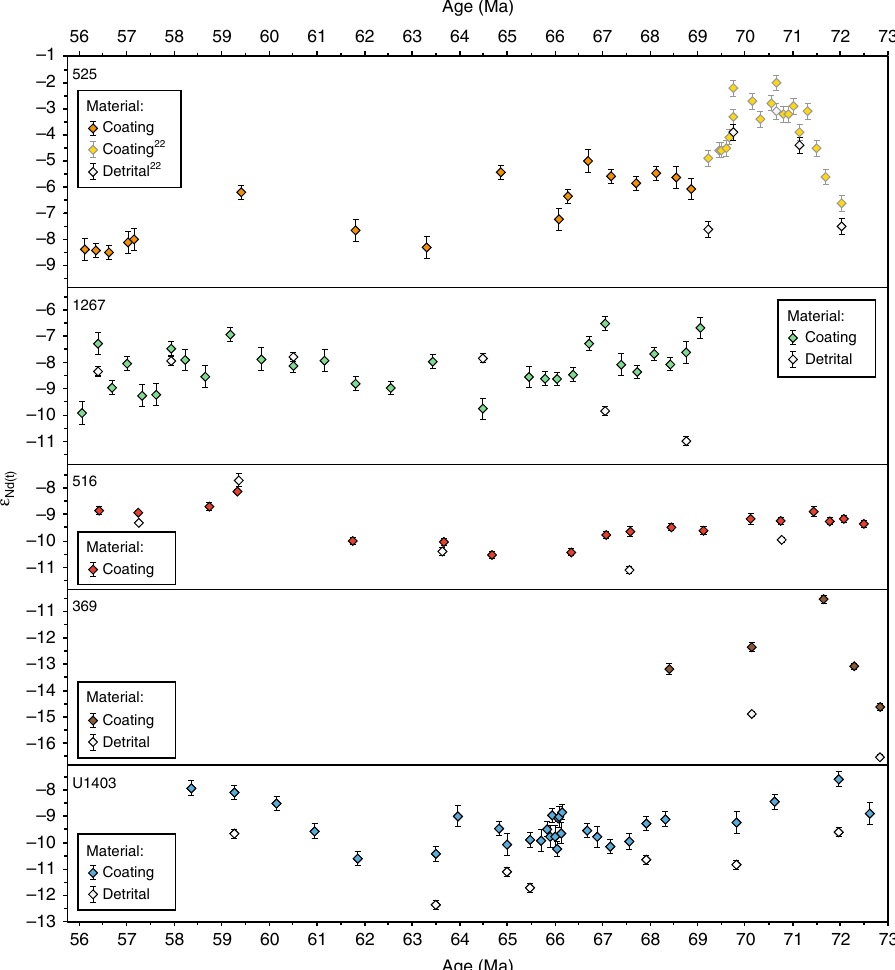
Fig. 3 New Nd-isotope results. Neodymium isotope values of ferromanganese coatings (coloured symbols) and detrital fractions (open symbols) measured in this study and previously for Site 525 22 . Error bars indicate 2 s.d. external